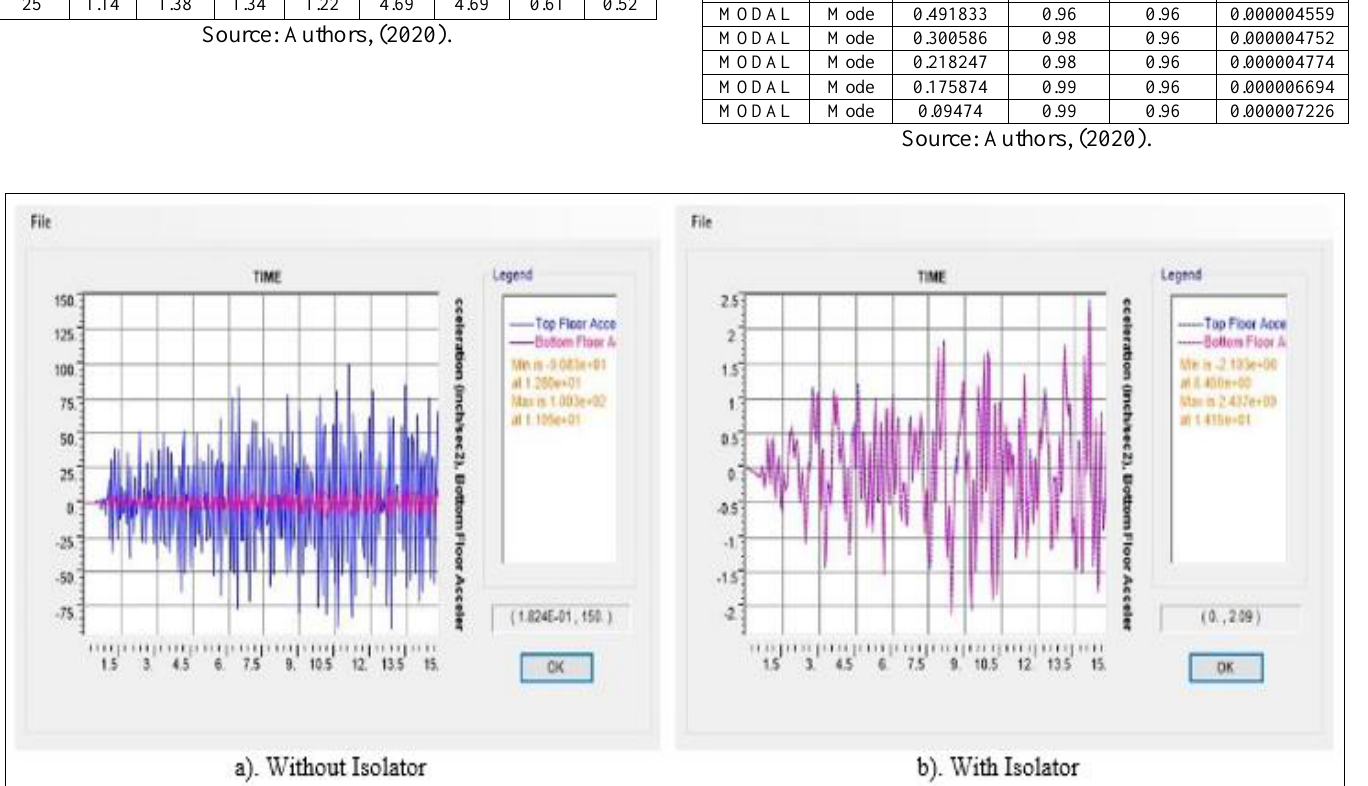
Figure 13: Top and bottom acceleration vs time curve (15 sec).